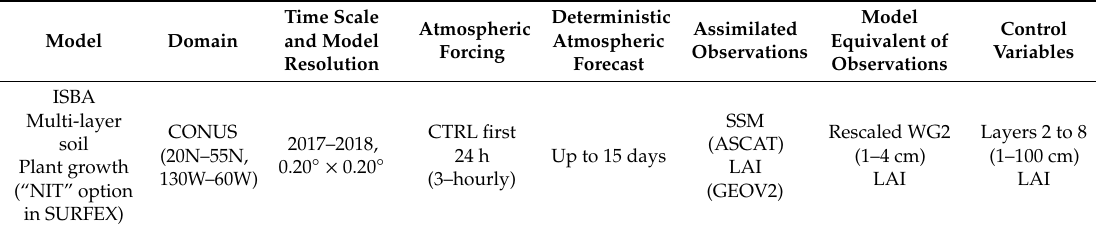
Table 1. Description of the LDAS-Monde data assimilation (DA) experiment used in this